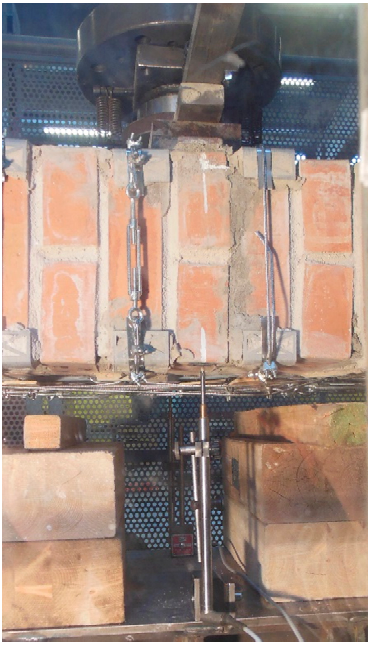
Figure 50. A snapshot of when the disconnection became visible for the first time (load value of about 27.122 kN), on the right of the middle cross-section: the stiffness of the longitudinal straps does not allow free rotation around the inner hinge (back view, the vertical white marks indicate the middle cross-section).